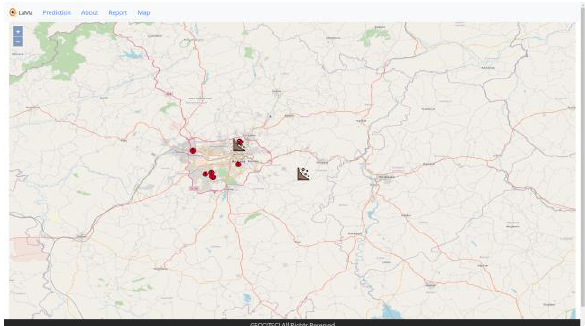
Figure 8. The symbols used on the demo application for landslide and non-landslide (red circles) data.